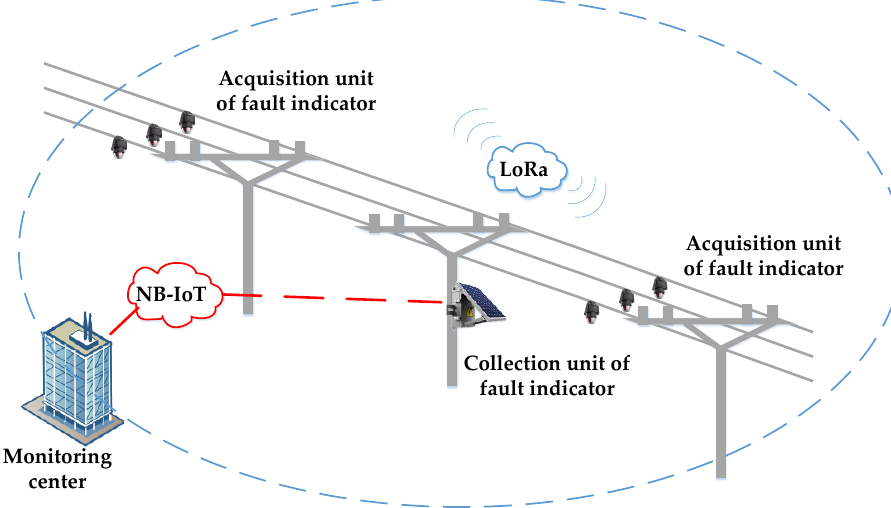
Figure 3. The working principle of fault indicator based on LoRa and NB-IoT.